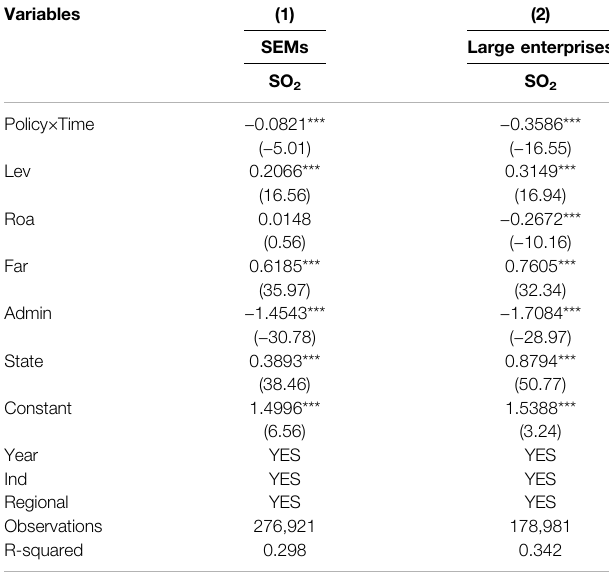
TABLE 5 | The green credit policy and SO 2 emissions: corporate